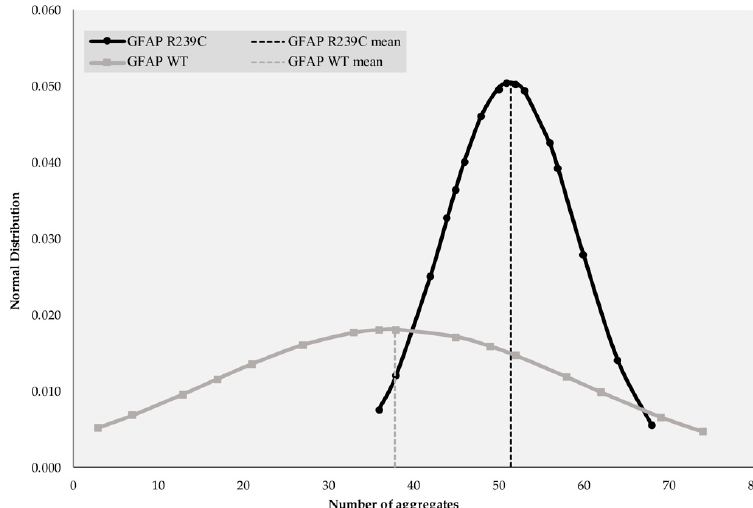
Figure 3. Gaussian distribution of GFAP R239C-GFP and GFAP WT-GFP aggregates. The number of aggregates and normal distribution are reported on the abscissa and ordinate axes, respectively. A p -value of 0.038 was found and standard deviations of ± 8.65 and ± 22.04 were obtained for GFAP